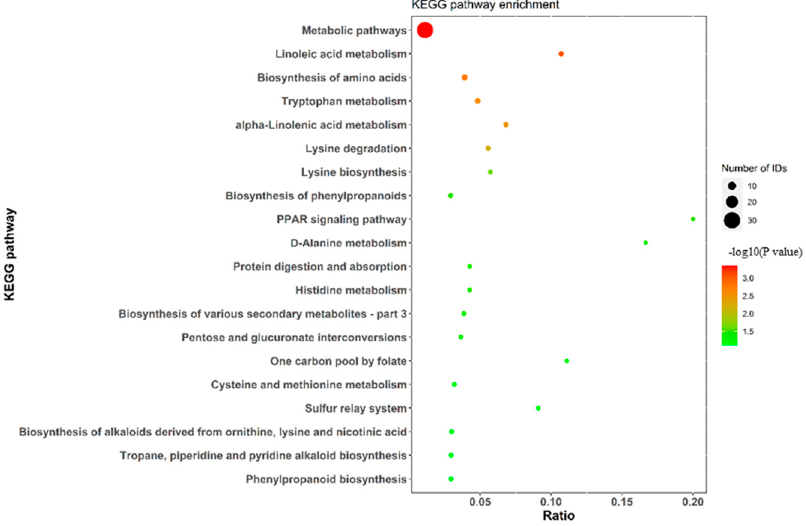
Figure 4. KEGG pathway enrichment analysis of differential metabolites of two cultivars. Table 1. Organic acids and derivatives in the germ substrates of two cultivars using two MS E modes. No.